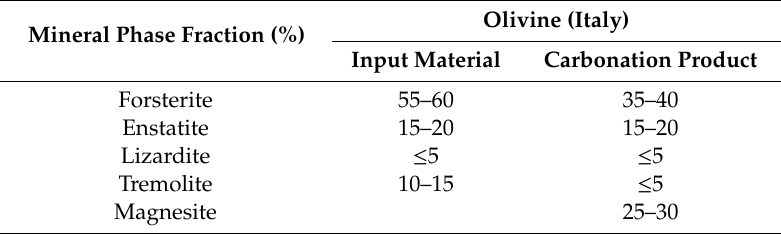
Table 3. Semi-quantitative examination of the present mineral phase fractions in Italian olivine before and after carbonation.